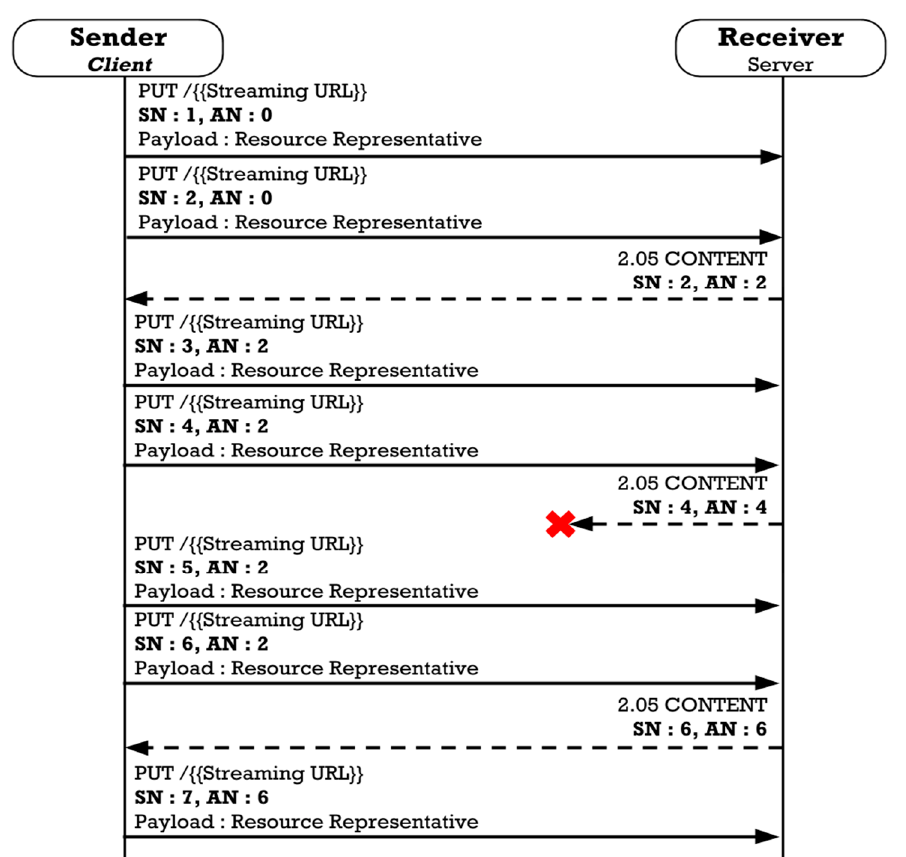
Figure 13. Example of flow control operations for CoAP-SC.